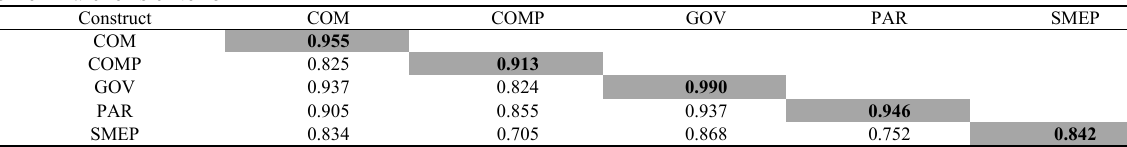
Fornell-Larcker’s criterion Construct COM